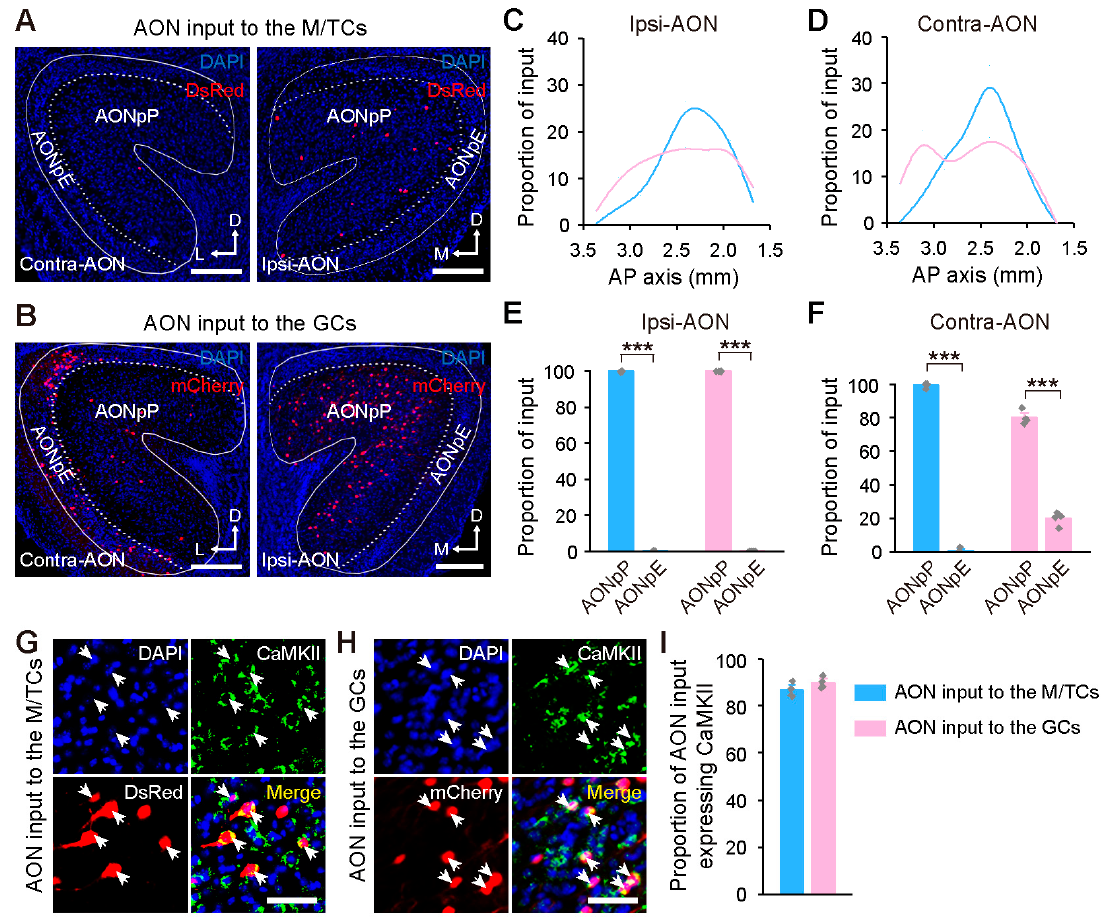
Figure 3. Organization of the centrifugal input from the AON to the OB. ( A , B ) Input neurons in the ipsilateral (left) and contralateral AONs (right) following retrograde tracing from the M/TCs ( A ) and GCs ( B ). ( C , D ) Cumulative distribution of the input neurons in the ipsilateral ( C ) and contralateral AONs ( D ) along the AP axis. ( E , F ) Subarea distribution of the input neurons in the ipsilateral ( E ) and contralateral AONs ( F ). Paired two-tailed t -tests, *** p < 0.001. ( G , H ) Identification of CaMKII-expressing input neurons in the ipsilateral AON (indicated by arrowheads) following retrograde tracing from the M/TCs ( G ) and GCs ( H ). ( I ) Proportion of CaMKII-expressing input neurons in the bilateral AONs. Data are shown as the mean ± s.e.m.; gray rhombuses denote individual animals in ( E , F , I ). Scale bars, 200 µm in ( A , B ); 50 µm in ( G , H ).